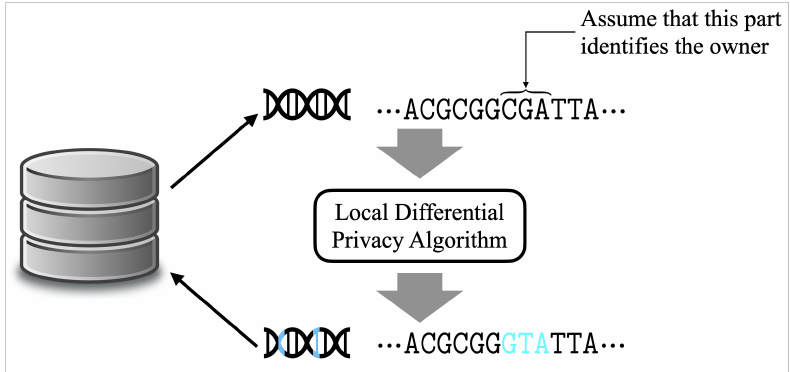
Figure 3. An example of attaching noise using local differential